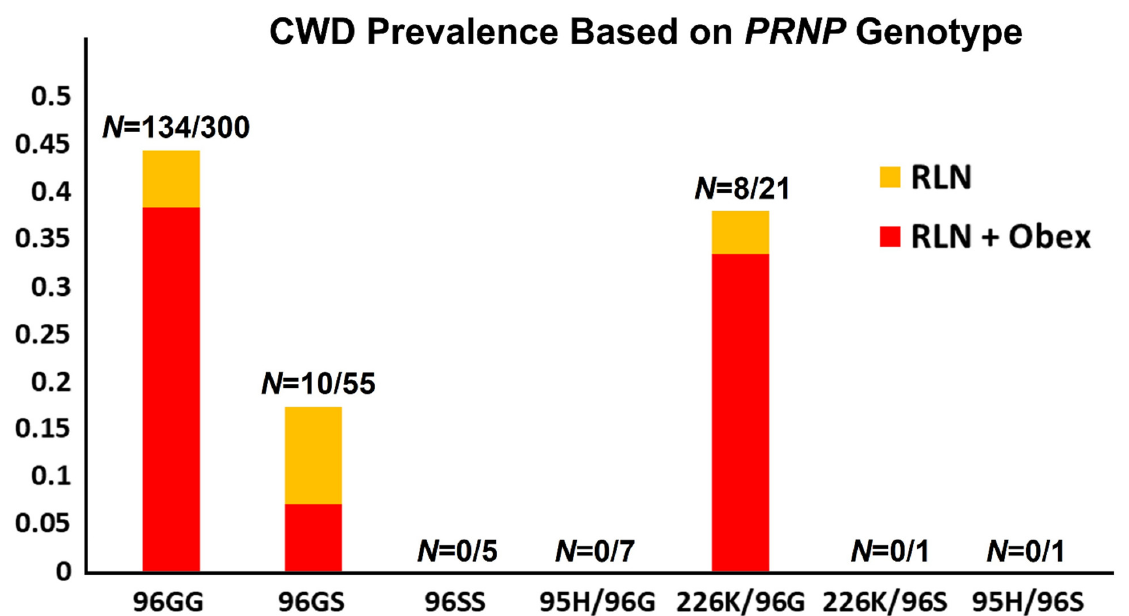
Figure 4. Prevalence of chronic wasting disease on hunting premises 1 and 2 based on genotype. As in previous studies, the 96GG genotype was overly represented among CWD-positive animals, two and a half times that of 96GS animals. Affected 96GG animals were also twice as likely to be in advanced stages of disease. Prevalence and disease stages of animals with 96G/226K genotypes were similar to those observed with 96GG animals. Only those genotypes found in harvested animals, which include animals from the first phase of the project and the initial year of phase two, are shown. Data from hunting premises 3, which has to date remained CWD-negative, are not included in the figure. Table 2. CWD prevalence among different PRNP genotypes on hunting sites 1 and 2 over the course of the study. Results include information from animals which were in early disease stages (positive in the retropharyngeal lymph nodes, RLN, only), as well as those in later disease stages that were positive in both the RLN and obex region of the brainstem. Animals with the 96GG genotype were overly represented among CWD-positive cases and tended to be in more advanced stages of disease compared to animals with the 96GS genotype. Data from hunting premises 3, which has to date remained CWD-negative, are not included in the table.